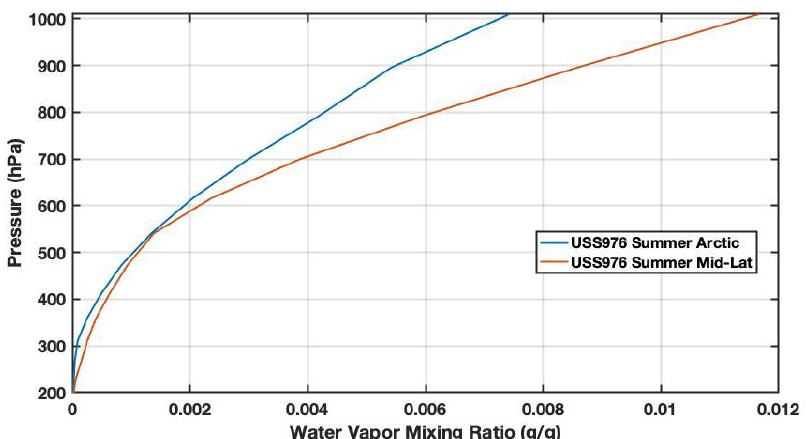
Figure 4. Difference between the summer mid-latitude and arctic USS976 water vapor mixing profile used to assess FLG sensitivity in computing the